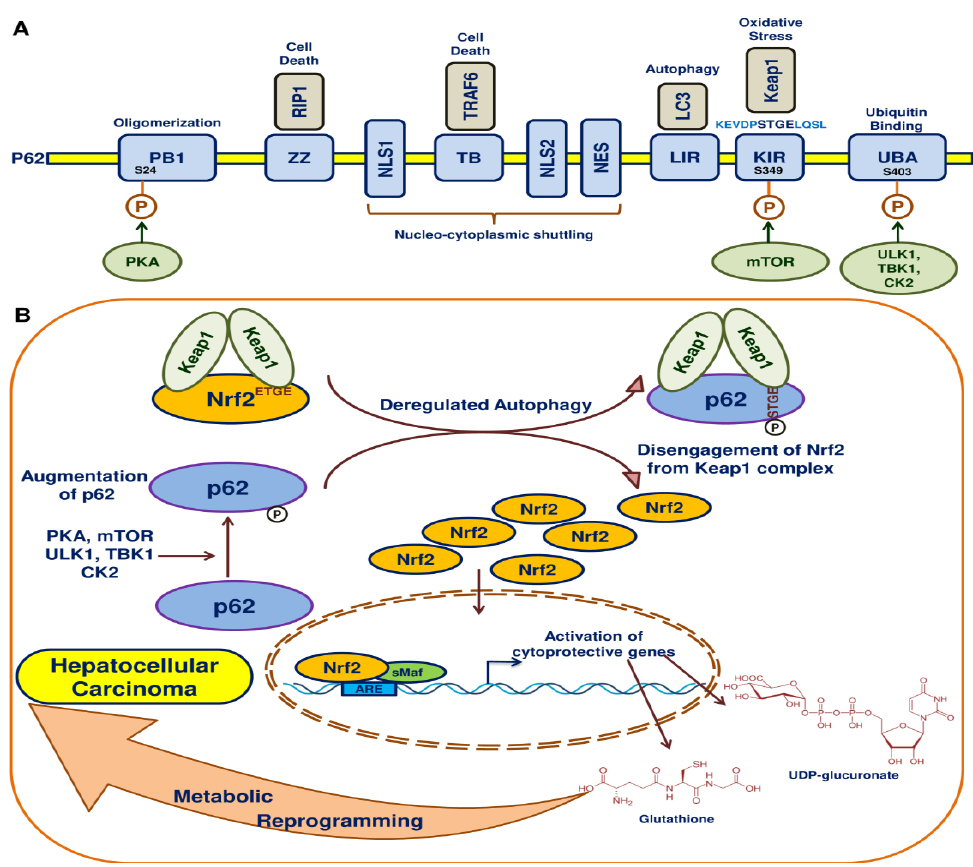
Figure 4. Autophagy, Keap1 and p62 regulate Nrf2 in HCC. ( A ) Domain structure of p62/Sqstm1. The domains of p62 and their interacting partners. ( B ) Under normal physiology, Nrf2 is held by Keap1 and directs Nrf2 for proteasomal degradation. During deregulated autophagy, augmentation of p62 occurs through phosphorylation of p62. Upon phosphorylation, p62 sequesters Keap1 and disengages Nrf2 from Keap1, leading to the activation of the Keap1-Nrf2-ARE pathway, which results in antioxidant defence, survival and metabolic reprogramming in HCC.